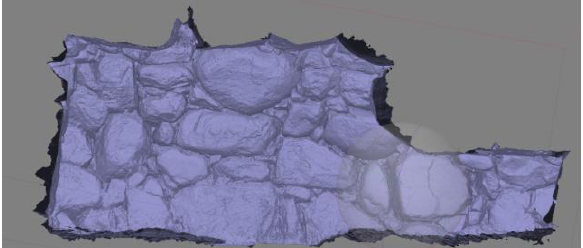
Figure 6. 3D model of the stone chamber in the Bentenzuka burial mound by SfM